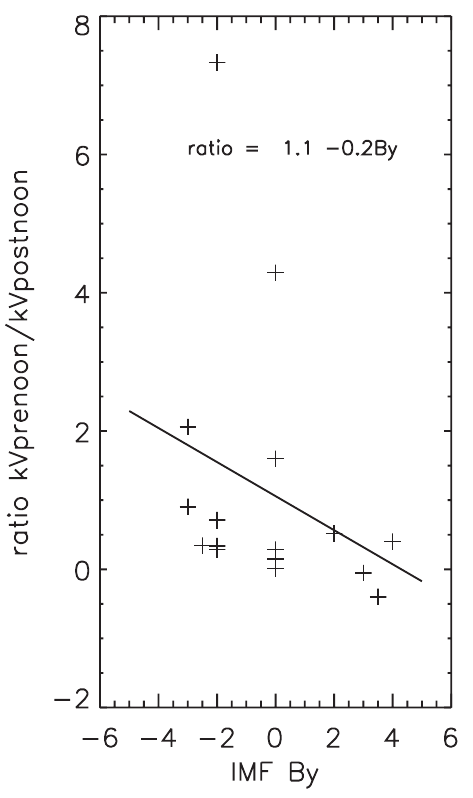
Figure 5. Ratio of prenoon to postnoon potential as a function of IMF B y . Fig. 5. Ratio of prenoon to postnoon potential as a function of IMF B y